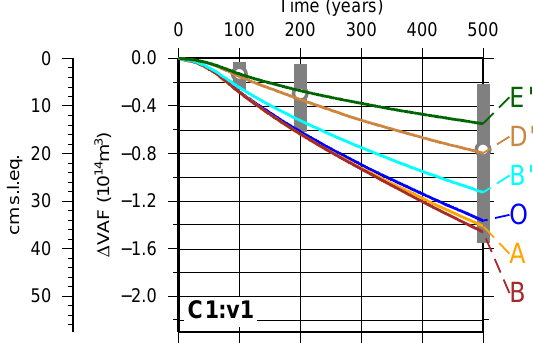
Figure 1. Simulated changes in VAF (volume above flotation, see the main text) obtained by future-climate runs under C1 (A1B cli- mate forcing), with “standard” sliding coefficient ( v1 ), in terms of the difference relative to the result of corresponding constant- climate experiments ( C0 ). Each line is a different experimental con- figuration of O (IcIES SeaRISE compatible), A , B , B (cid:48) , D (cid:48) , and E (cid:48) . The vertical gray bars indicate the range of results summarized in the SeaRISE (Bindschadler et al., 2013, Table 3) at 100, 200, and 500 years. The circles in the gray bars indicate the mean values of all the SeaRISE participants.